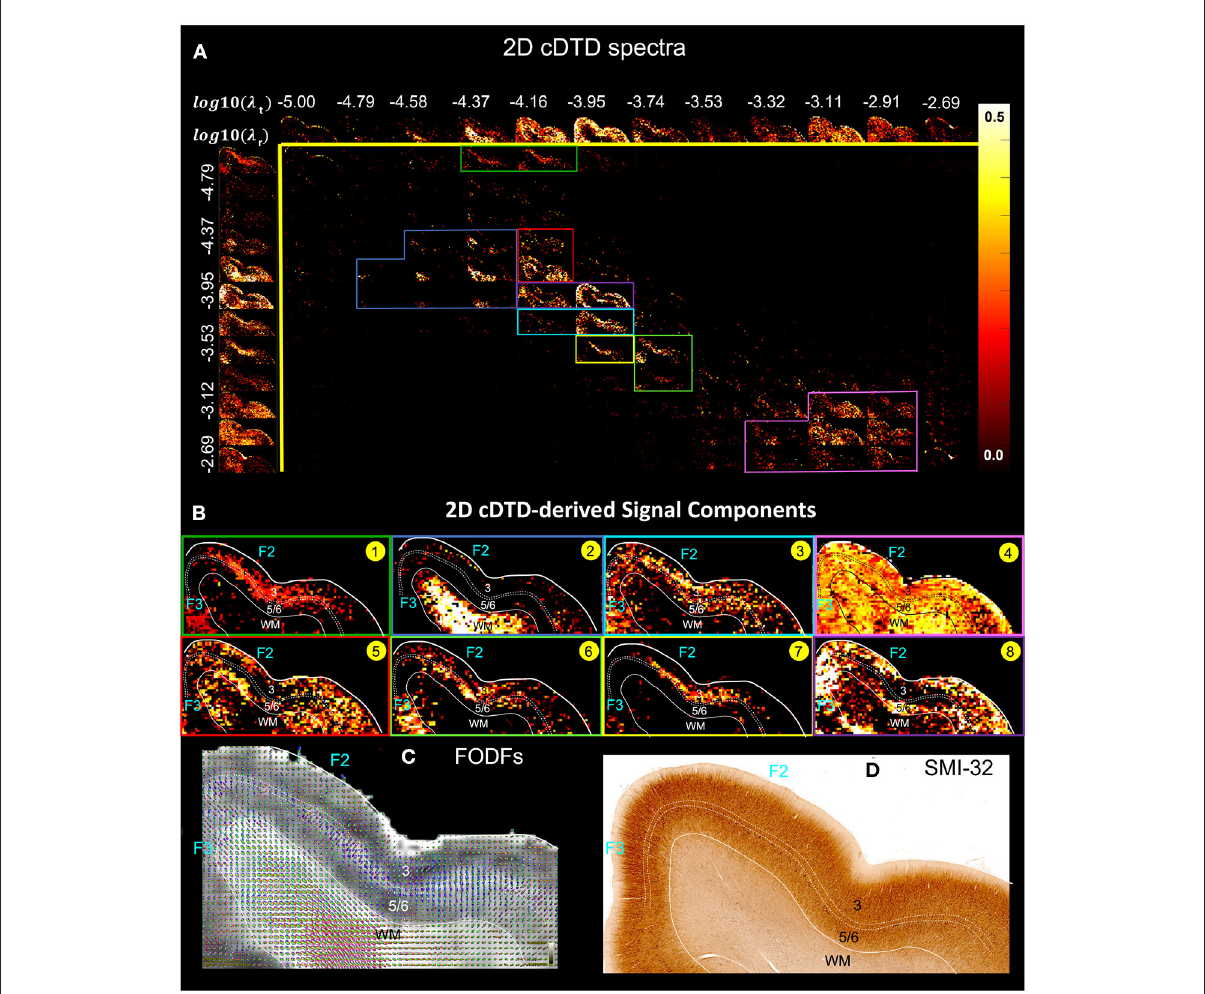
FIGURE6 (A) Spectral component maps of normalized 2D correlation spectra of radial and tangential diffusivities in a section of the cortex from Figure 5A. Top row: Spectral component maps of the normalized 1D marginal distribution of tangential diffusivity, λ t ; Left column: Spectral component maps of the normalized 1D marginal distribution of radial diffusivity, λ r . (B) Tissue component maps derived by integrating the 2D cDTD spectral components over empirically defined spectral regions of interest delineated with different colors show good specificity to cortical layers. (C) Corresponding FODs. (D) Corresponding SMI-32 stained